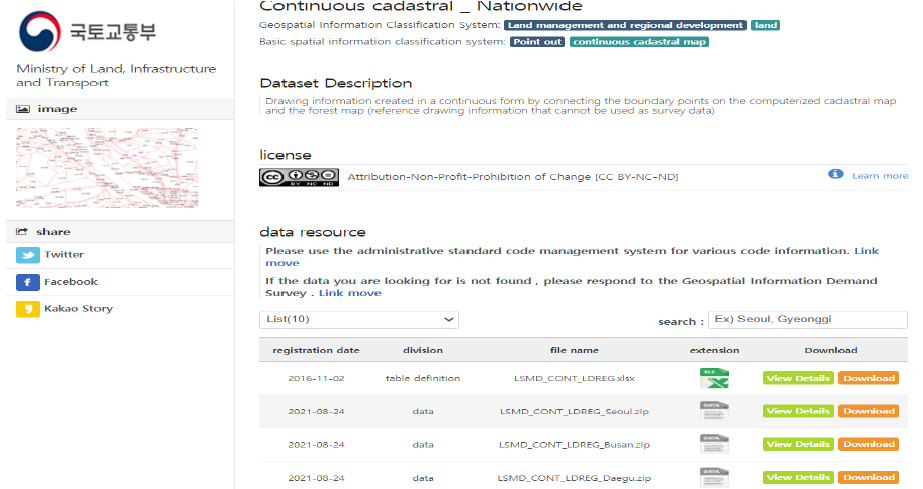
Figure 5. Spatial dataset provided by ‘Open market’.